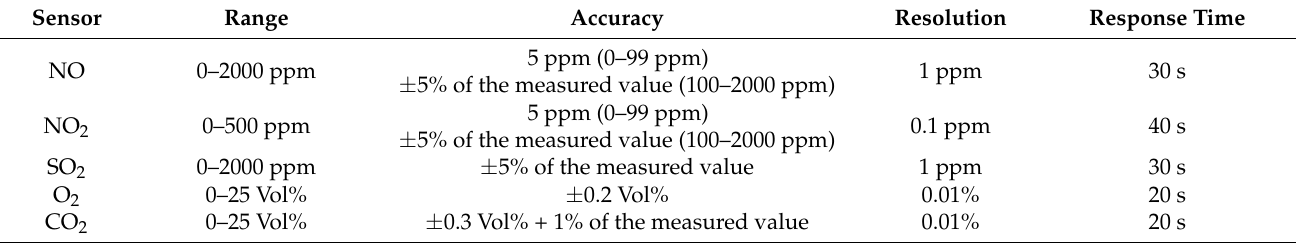
Figure 3. The packing equipment used in the experiment. ( a ) Cannon rings; ( b ) Pall rings; ( c ) Dixon rings. Table 1. The information obtained from TESTO Pro.350.